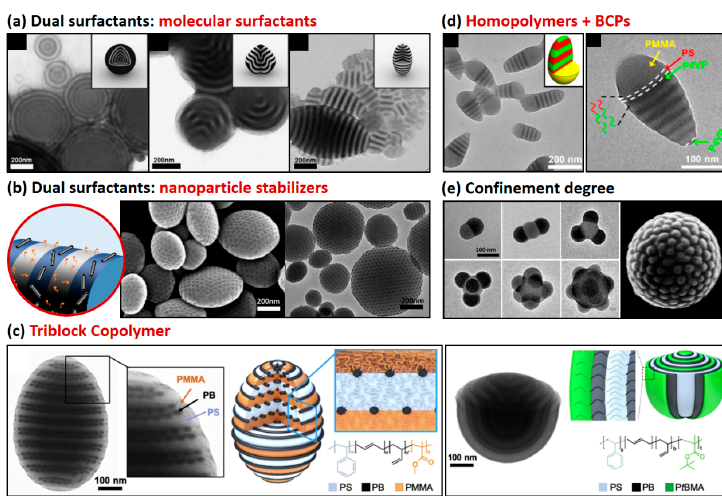
Figure 2. Interfacial engineering of BCP particles to produce non-spherical BCP particles by surface neutralization. ( a ) Transmission electron microscopy (TEM) images of symmetric polystyrene-block-polybutadiene (PS- b -PB) prepared by mixed surfactants of polystyrene-block-poly(ethyl oxide) (PS-PEO) and polybutadiene-block-poly(ethyl oxide) (PB-PEO) at different mixing ratios: spherical, tulip-bulb, and prolate particles (reprinted with permission from [41], Copyright 2008, Wiley-VCH). ( b ) Scanning electron microscopy (SEM) and TEM images of oblate polystyrene-block-poly(4-vinyl pyridine) (3-pentadecylphenol) (PS- b -P4VP (PDP)) particles prepared by a mixture of cetyl trimethyl ammonium bromide (CTAB) and oleic acid-coated Au NPs (reprinted with permission from [42], Copyright 2014, American Chemical Society). ( c ) TEM images of prolate PS- b -PB- b -PMMA triBCP (PMMA: poly(methyl methacrylate; triBCPs: triblock copolymer) particles stabilized by the mixture of CTAB and poly(vinyl alcohol) (PVA) and tulip-bulb-like particles of PS- b -PB- b -PtBMA triBCPs (PtBMA: poly(t-butyl methacrylate)) stabilized by CTAB as a sole surfactant (reprinted with permission from [43], Copyright 2019, American Chemical Society, and [44], Copyright 2019, Wiley-VCH). ( d ) TEM images of conical Janus particles comprised of PS- b -P4VP and PMMA bends (reprinted with permission from [45], Copyright 2014, American Chemical Society). ( e ) TEM images of PS- b -P4VP patchy particles with a tunable number of bulbs and SEM image of raspberry-like PS- b -P4VP particles (reprinted with permission from [29,46], Copyright 2015 and 2012, American Chemical